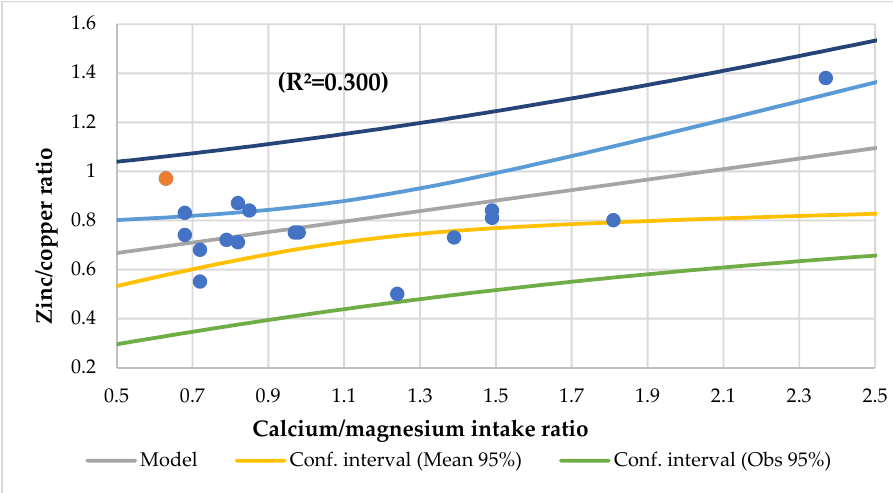
Figure 7. Regression zinc/copper ratio by calcium/magnesium intake ratio.